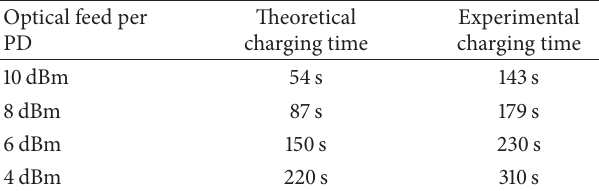
Figure 2: Experimental IV curves of the 1 × 8 PD array. Table 1: Charging time of 0.1F SC (from 0 V to 4.6V).